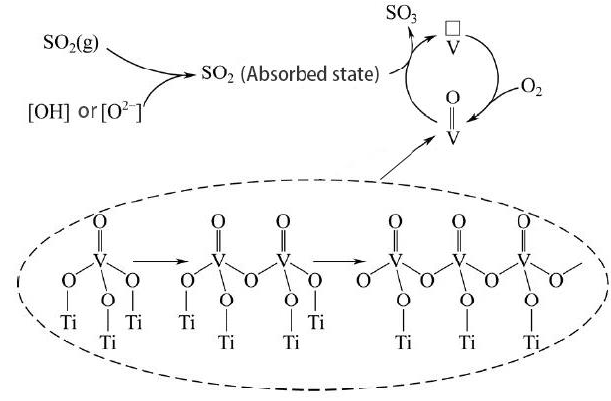
Figure 10. Mechanism of SO 2 oxidation on the surface of vanadium-based catalysts [92].